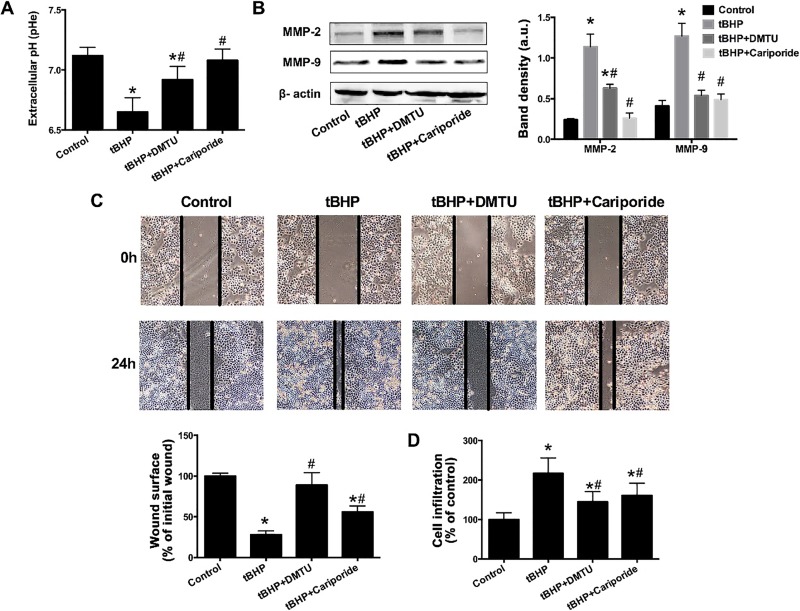
Inhibition of NHE1 decreased the ROS-induced migration of OS cells. pHe (A), immunoblots of MMP-2 and MMP-9 (B), wound healing ability (C), and invasion (D) were analyzed after treating U2OS cells with 1 μM tBHP alone or in combination with DMTU or cariporide. Data represent mean ± SD of N = 5. *P < 0.05 versus control. #P < 0.05 versus the tBHP group.